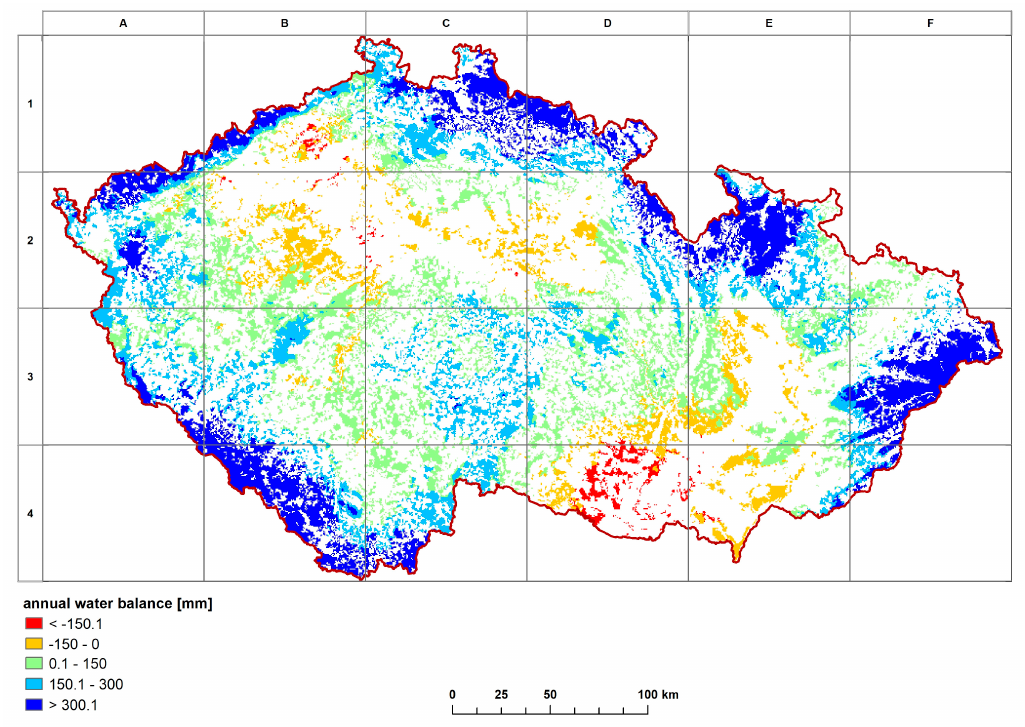
Figure 3. Categories of high temperature (HT) risk based on long-term annual number of tropical days (TDs).